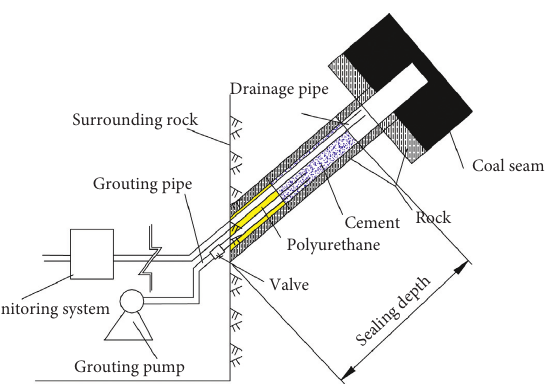
Figure 15: Arrangement of the experiment boreholes.